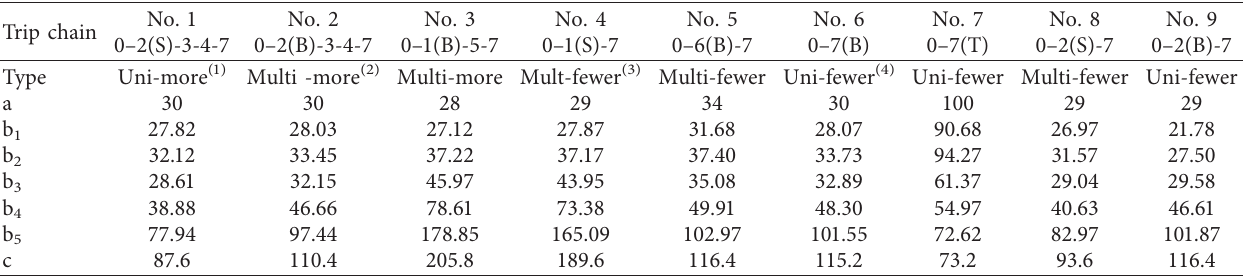
Table 5: The harvest of different trip chains of seven groups of travelers.